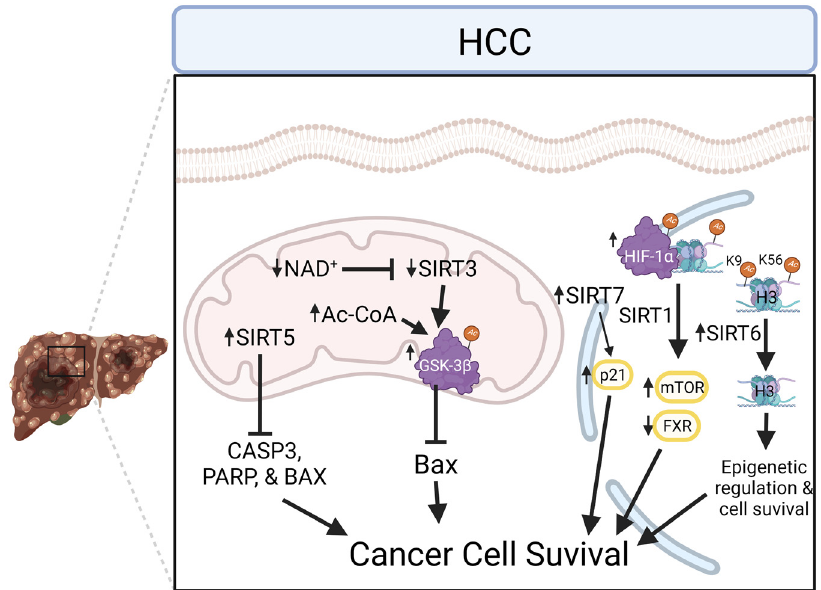
Figure 6. Pathological progression of hepatocellular carcinoma (HCC) via the manipulation of cellular defense mechanisms provides an unclear role for sirtuins. The decrease in NAD + limits SIRT3 activity resulting in the acetylation of GSK-3 β which regulates Bax inhibiting apoptosis. Furthermore, SIRT5 was observed to be upregulated to decrease apoptotic signals. Within the nucleus protein and histone acetylation influence transcription factors and epigenetic regulation of increase cell survival. Bax, BCL2-associated X protein; CASP3, caspase 3; H3, Histone H3; FXR, farnesoid X receptor; GSK-3 β , glycogen synthase kinase-3 β ; mTOR, mammalian target of rapamycin; PPAR, peroxisome proliferator-activated receptor; SIRT, sirtuin.